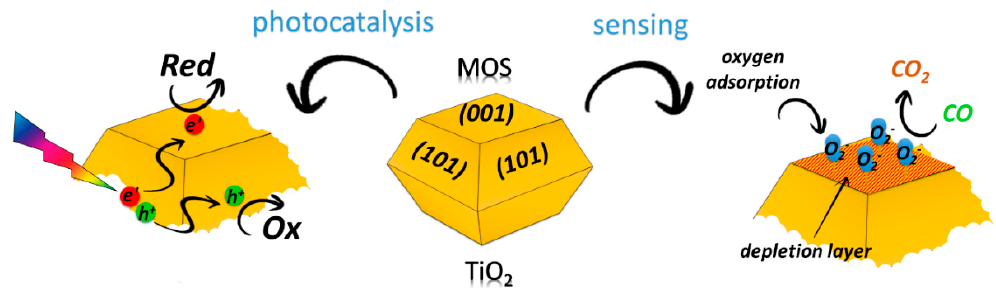
Figure 1. Mechanism of facet-dependent photocatalysis and (bio)chemical sensing for specifically shaped metal oxide semiconductor (MOS), Red—reduction, Ox—oxidation processes.